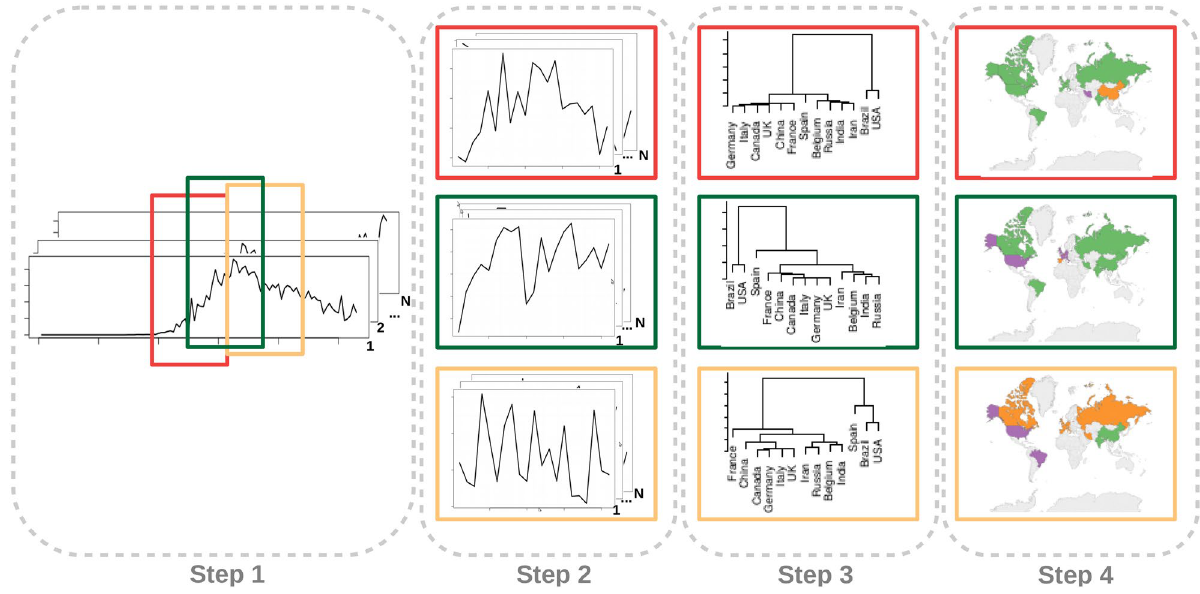
Figure 12. General overview about the proposed approach. Firstly (left-most), the time series are aligned by considering a reference country. Then (middle), we calculated the distance matrix that will be used by the clustering algorithm (right-most).